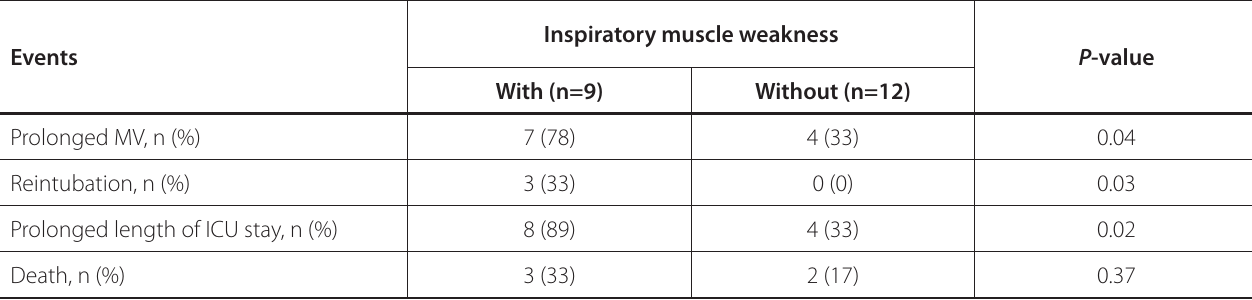
Table 2 . Patients with or without respiratory muscle weakness regardless of short-term